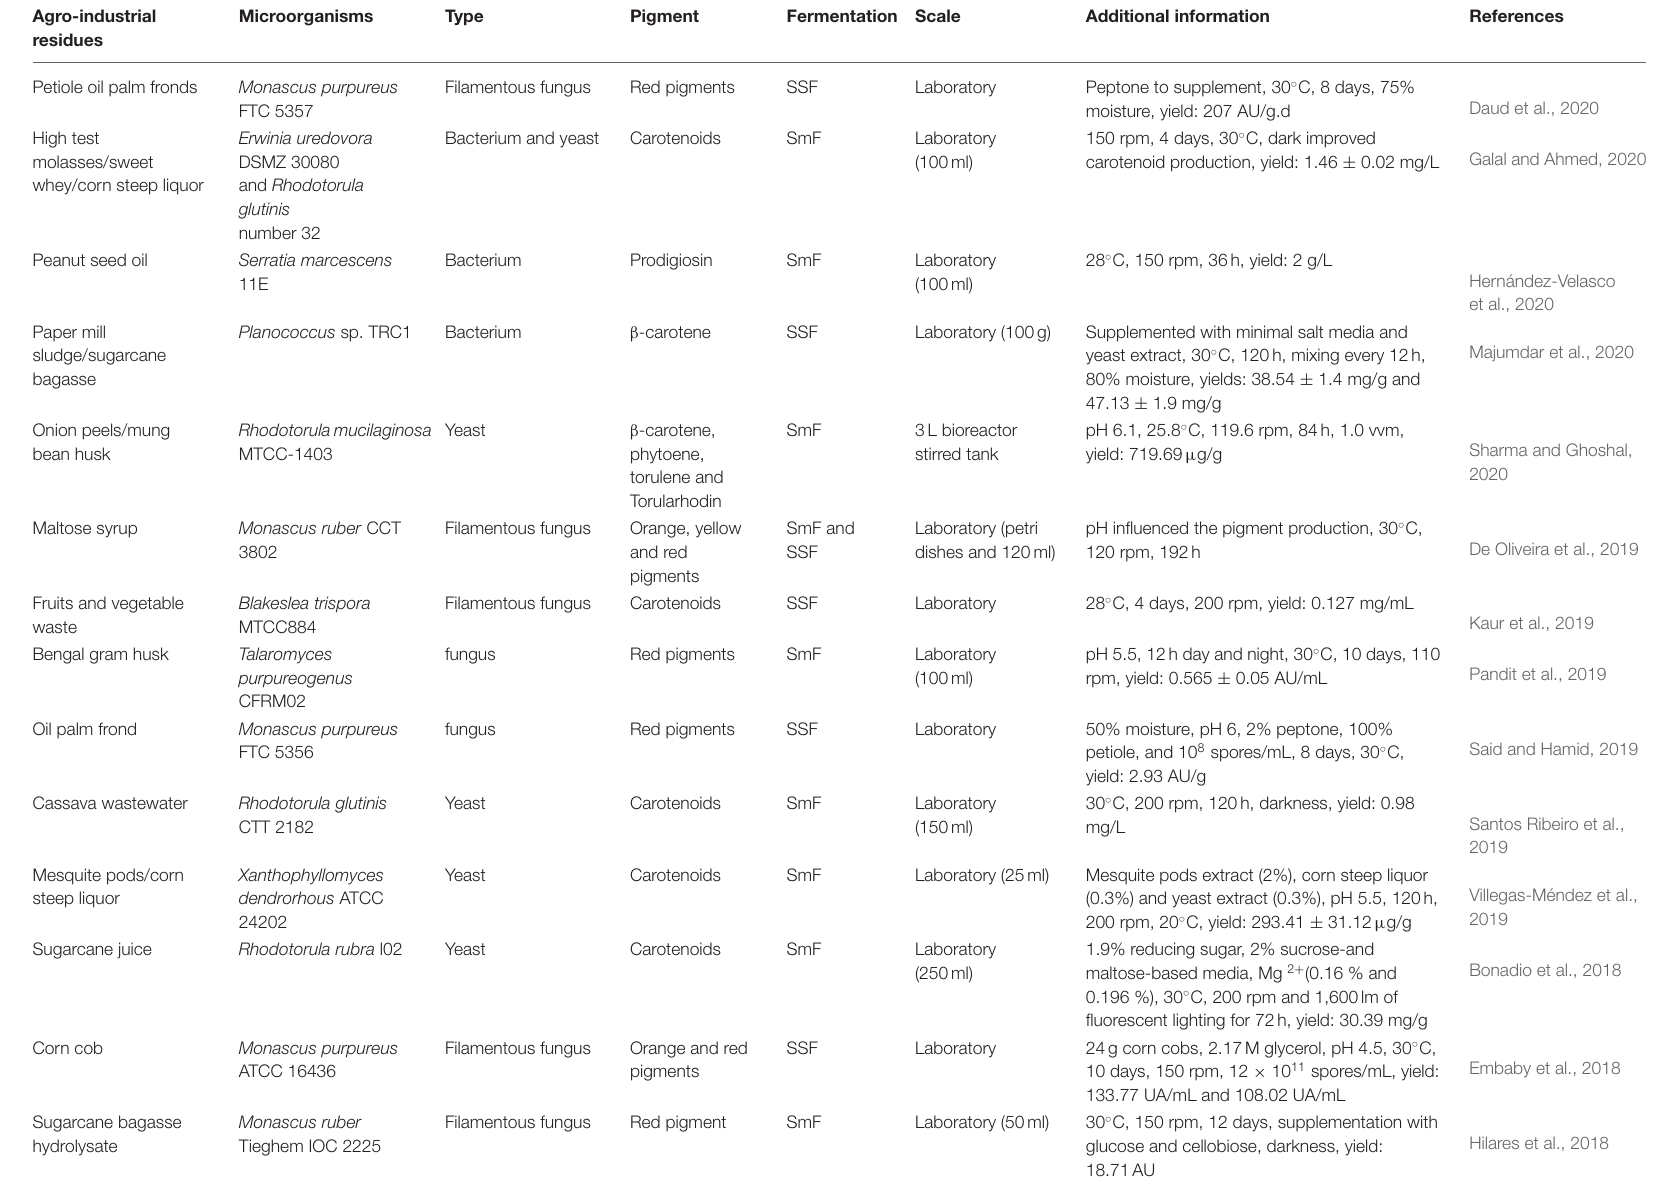
TABLE 2 | Microbial pigments produced with agro-industrial waste and fermentation conditions